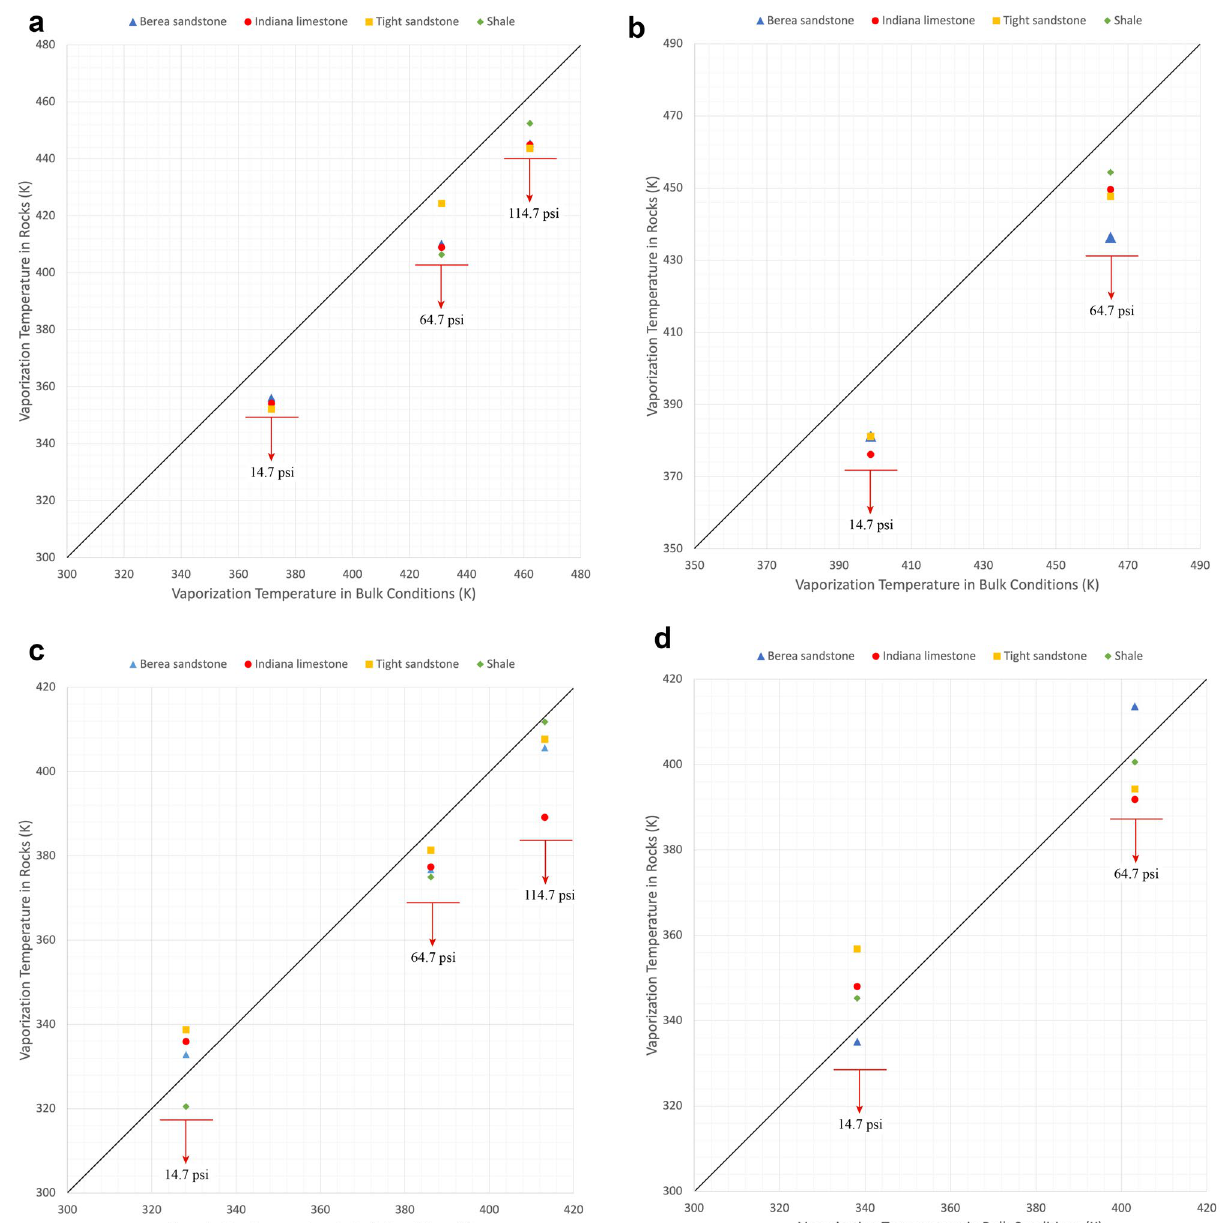
Figure 8. ( a ) Deviation of measured vaporization temperatures of heptane from bulk measurements. ( b ) Deviation of measured vaporization temperatures of octane from bulk measurements. ( c ) Deviation of measured vaporization temperatures of pentane-heptane mixture from bulk measurements. ( d ) Deviation of measured vaporization temperatures of pentane-heptane-octane mixture from bulk